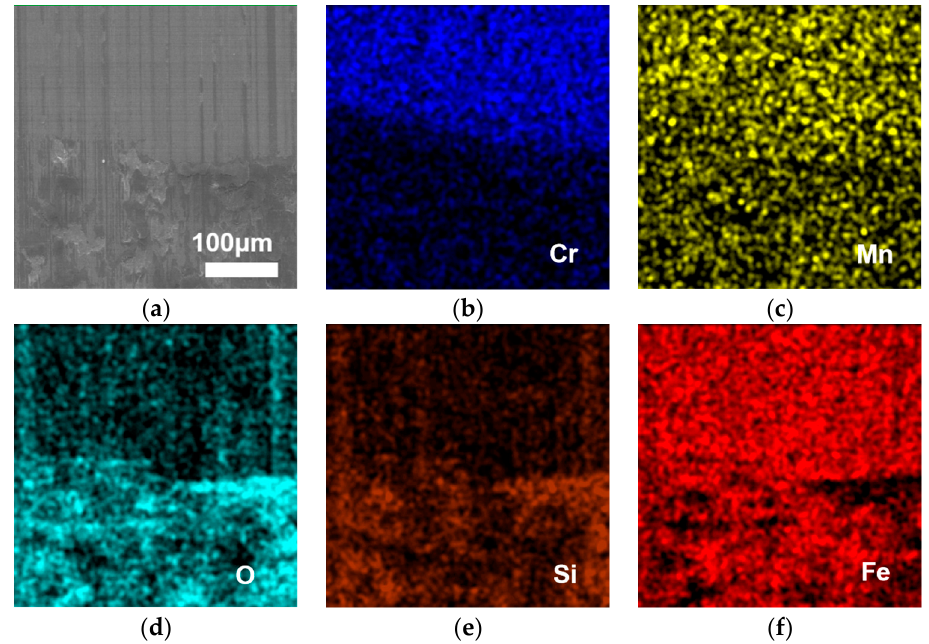
Figure 11. Fe-based interface EDS images. This is the interface between the substrate and the coating, and the difference in materials can be seen. The upper part is the coating, and the lower part is the substrate. The elements at the interface had migrated due to laser-cladding and friction tests. Therefore, the content of each element had some deviation. ( a ) The interface of Fe-based at 100 µ m of the scale; ( b ) Distribution of Cr atom at the interface; ( c ) Distribution of Mn atom at the interface; ( d ) Distribution of O atom at the interface; ( e ) Distribution of Si atom at the interface; ( f ) Distribution of Fe atom at the interface.